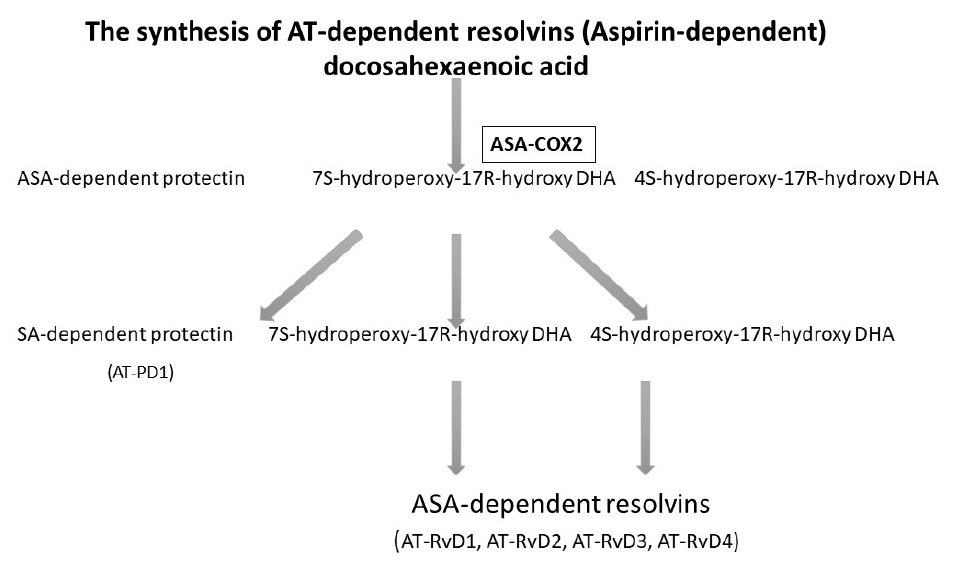
Figure 1. The biosynthesis of resolvins D with the presence of acetylsalicylic acid (ASA) [38,39]. Rv, resolvin.